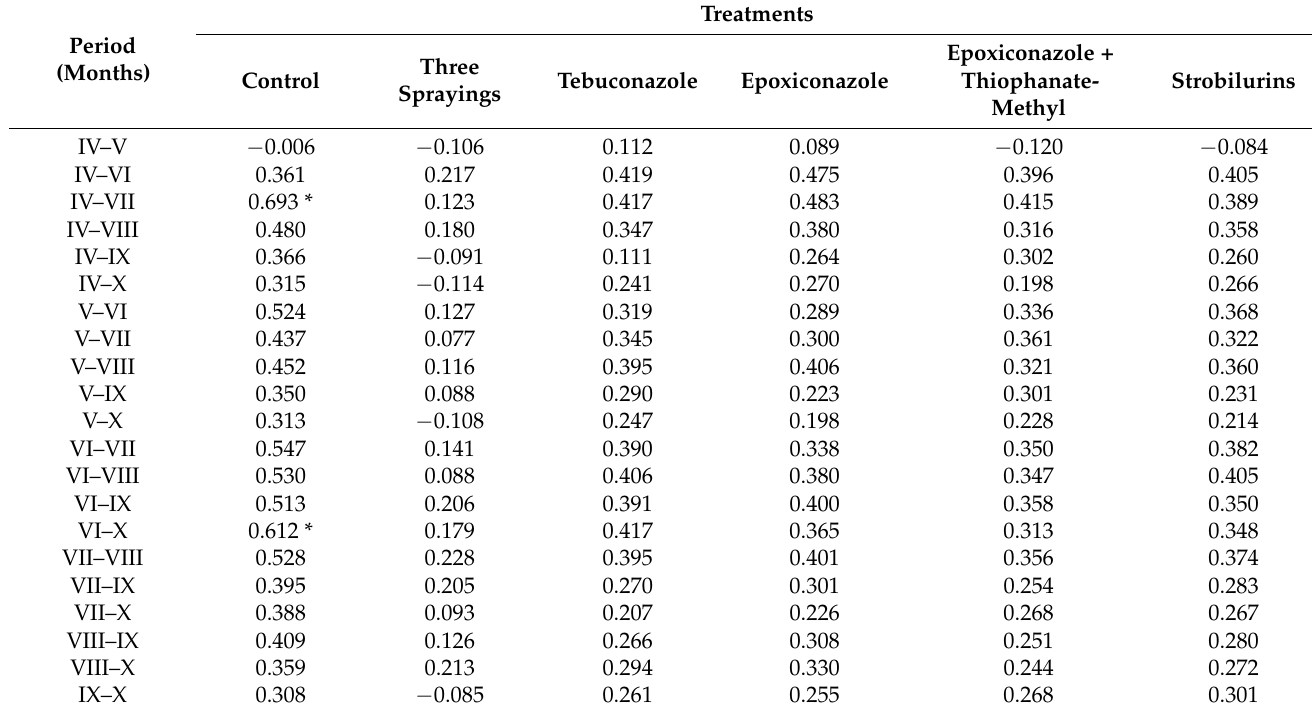
Table 6. Correlation coefficients * of degree of leaf infestation and sum of precipitation in different periods of sugar beet vegetation, by fungicidal protection